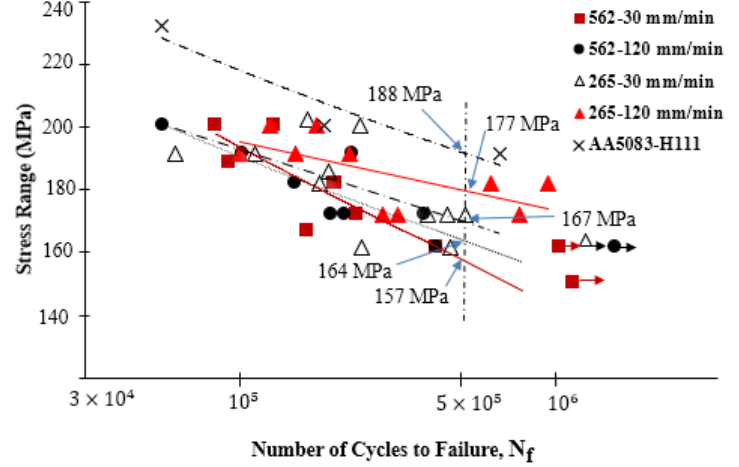
Figure 14. Fracture surface morphology of a specimen in the ( a ) 562-30 and ( b ) 562-280 series.